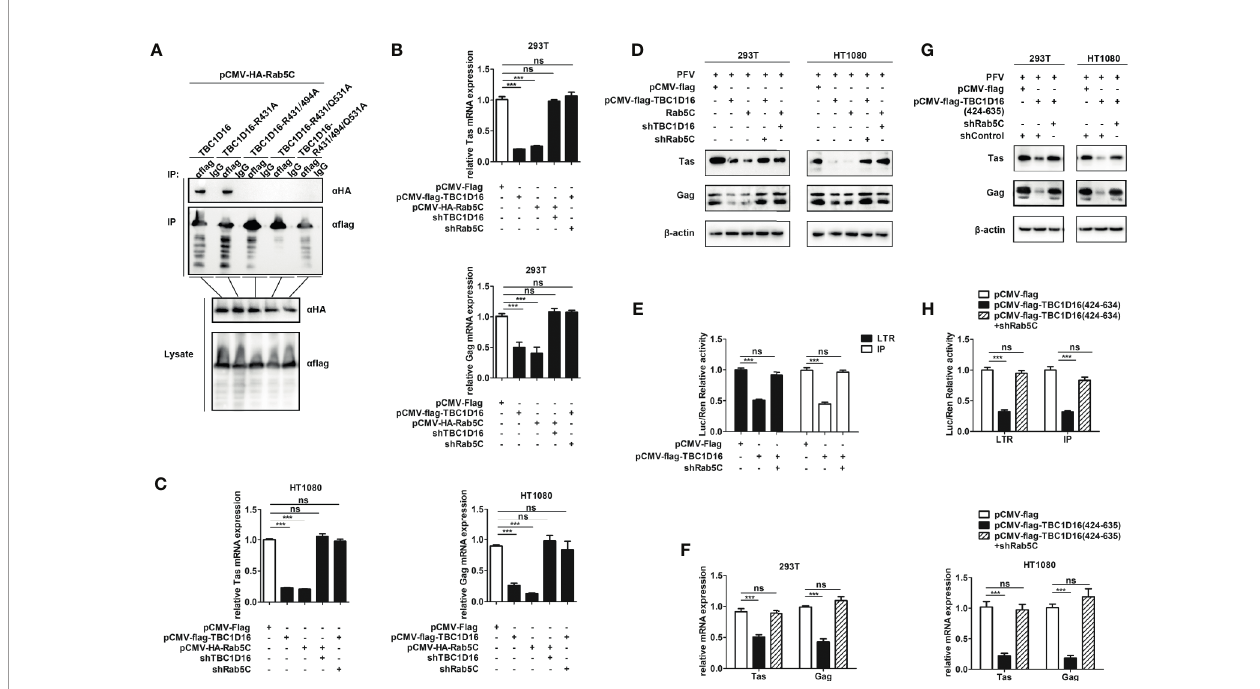
FIGURE 8 | The interaction between TBC1D16 and Rab5C is essential to inhibit PFV replication. (A) The interaction of Rab5C and TBC1D16. pCMV-Flag-TBC1D16 speci fi c locus mutant plasmids (3 m g) and pCMV-HA-Rab5C (3 m g) were cotransfected into HEK293T cells for 48 h. Co-immunoprecipitation and immunoblot analysis were used to detect the interaction between TBC1D16 with different locus mutants and Rab5C in HEK293T cells. (B, C) pCMV-Flag-TBC1D16 or pCMV- HA-Rab5C and pCMV-Flag (as an empty control) were transfected into HEK293T and HT1080 cells for 24 h. In another group, pCMV-HA-Rab5C and speci fi c shRNA of TBC1D16 or pCMV-Flag-TBC1D16 and speci fi c shRNA of Rab5C were cotransfected into HEK293T and HT1080 cells for 24 h. After transfection, cells were infected with PFV (MOI = 0.5) for 48 h. The mRNA expression of Tas and Gag was detected by qPCR (*** p < 0.001 and ns , no signi fi cance). (D) pCMV-Flag- TBC1D16 or pCMV-HA-Rab5C and pCMV-Flag (as an empty control) were transfected into HEK293T and HT1080 cells for 24 h. In another group, pCMV-HA- Rab5C and speci fi c shRNA of TBC1D16 or pCMV-Flag-TBC1D16 and speci fi c shRNA of Rab5C were cotransfected into HEK293T and HT1080 cells for 24 h. After transfection, cells were infected with PFV (MOI = 0.5) for 48 h. The protein expression of Tas and Gag was detected by western blot analysis. (E) pCMV-Flag- TBC1D16 (400 ng), pRL-TK (3 ng), pTK-Tas (30 ng for pGL3-PFV-LTR-luc or 20 ng for pGL3-PFV-IP-luc) and pGL3-PFV-LTR-luc (30 ng) or pGL3-PFV-IP-luc (20 ng) fi re fl y luciferase reporter plasmid were cotransfected with speci fi c shRNA of Rab5C into HEK293T cells for 48 h. Luciferase reporter assay was used to detect the LTR and IP promoter activity (Renilla luciferase as an internal control) (*** p < 0.001 and ns , no signi fi cance). (F, G) pCMV-Flag-TBC1D16 (424-635) and pCMV- Flag (as an empty control) were transfected into HEK293T and HT1080 cells for 24 h. These cotransfected plasmids were combined with or without speci fi c shRNA of Rab5C. After transfection, cells were infected with PFV (MOI = 0.5) for 48 h. The mRNA or protein expression of PFV Tas and Gag was detected by qPCR and western blotting (*** p < 0.001 and ns , no signi fi cance). (H) pCMV-Flag-TBC1D16 (424-635) (400 ng), pRL-TK (3 ng), pTK-Tas (30 ng for pGL3-PFV-LTR-luc or 20 ng for pGL3-PFV-IP-luc) and pGL3-PFV-LTR-luc (30 ng) or pGL3-PFV-IP-luc (20 ng) fi re fl y luciferase reporter were cotransfected with speci fi c shRNA of Rab5C into HEK293T cells for 48 h. Luciferase reporter assay was used to detect the LTR and IP promoter activity (Renilla luciferase as an internal control) (*** p < 0.001 and ns , no signi fi